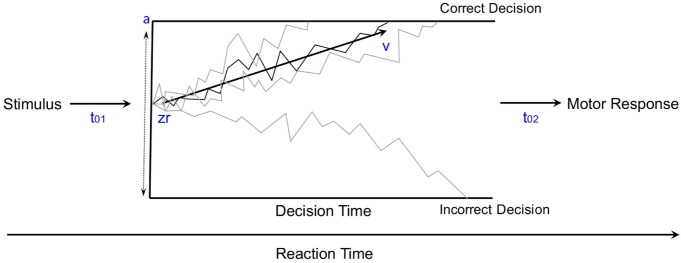
The diffusion model of decision-making illustrated for pedagogical purposes with several different types of learning curves [modified from Ratcliff and McKoon (31)].